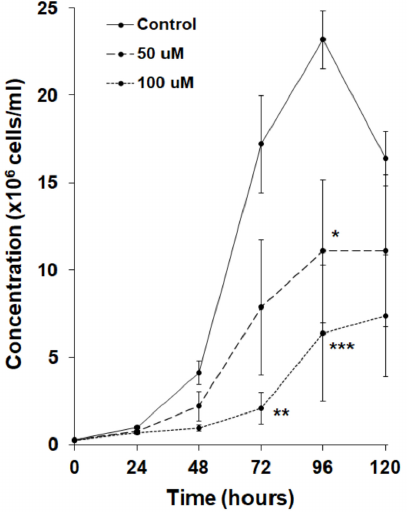
Figure 3. Effect of MLN4924 on cell proliferation. Cells were grown in HL5 medium in the presence and absence of MLN4924 (50 µ M, 100 µ M, control: dimethyl sulfoxide) over a period of 5 days (120 h). Data presented as the mean concentration ( × 10 6 cells/mL) ± SEM ( n ≥ 4). Statistical significance was assessed using two-way ANOVA followed by Bonferroni post-hoc analysis. Two-way ANOVA revealed a significant effect of MLN4924 treatment on the growth curves ( p < 0.0001). * p < 0.05, ** p < 0.01, and *** p < 0.001 vs. control at the indicated time points as determined from Bonferroni post-hoc